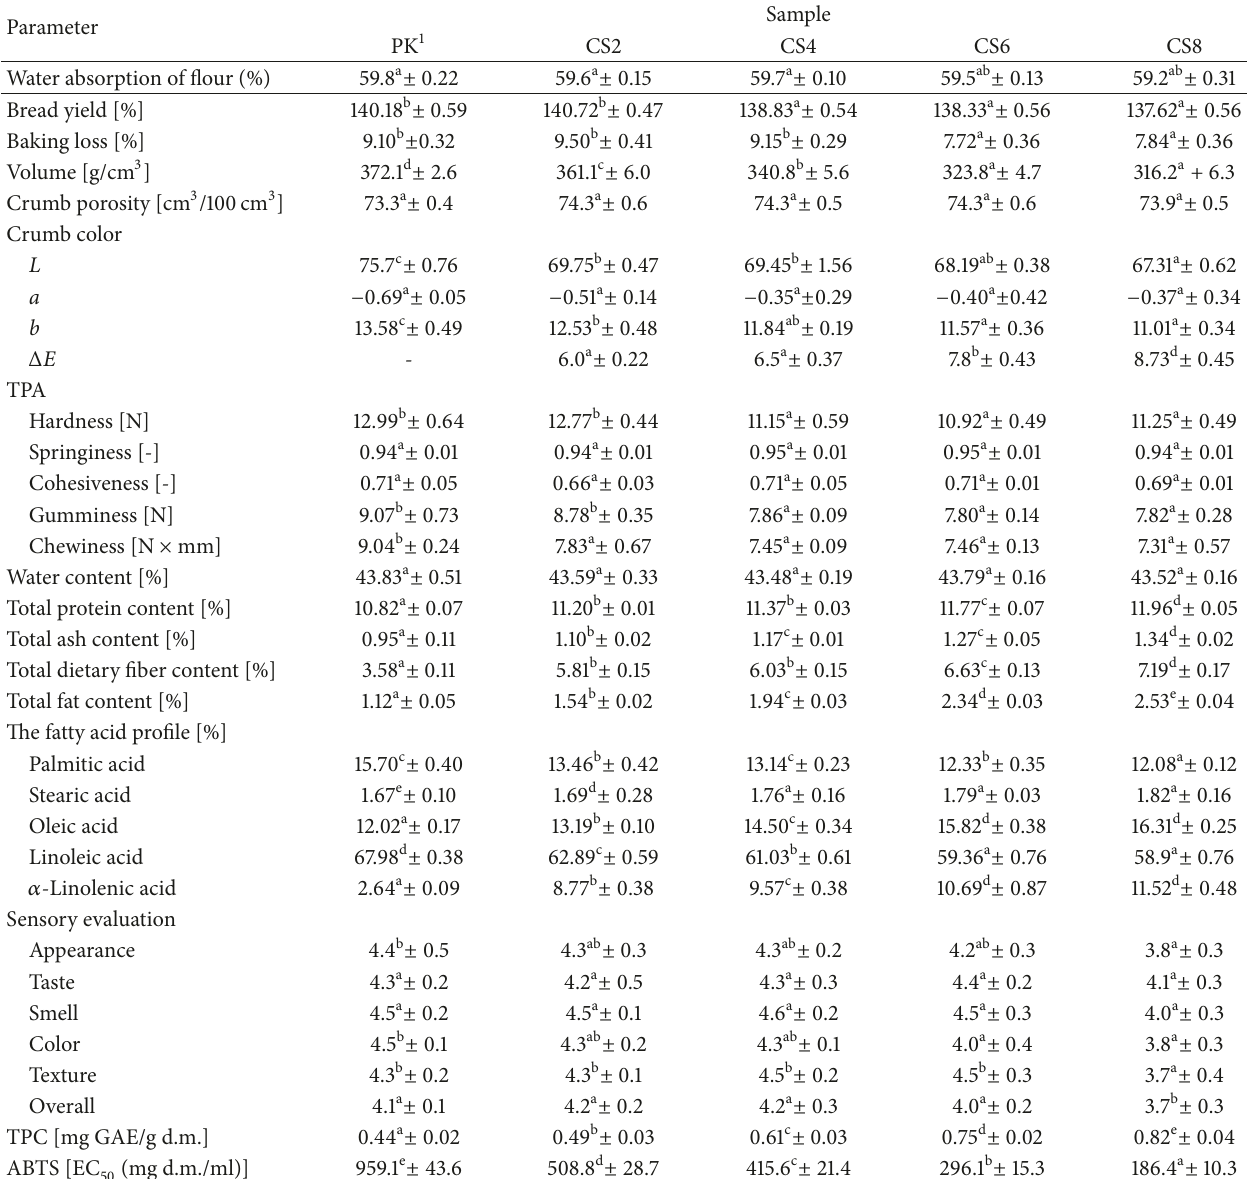
Table 3: Characteristics of obtained